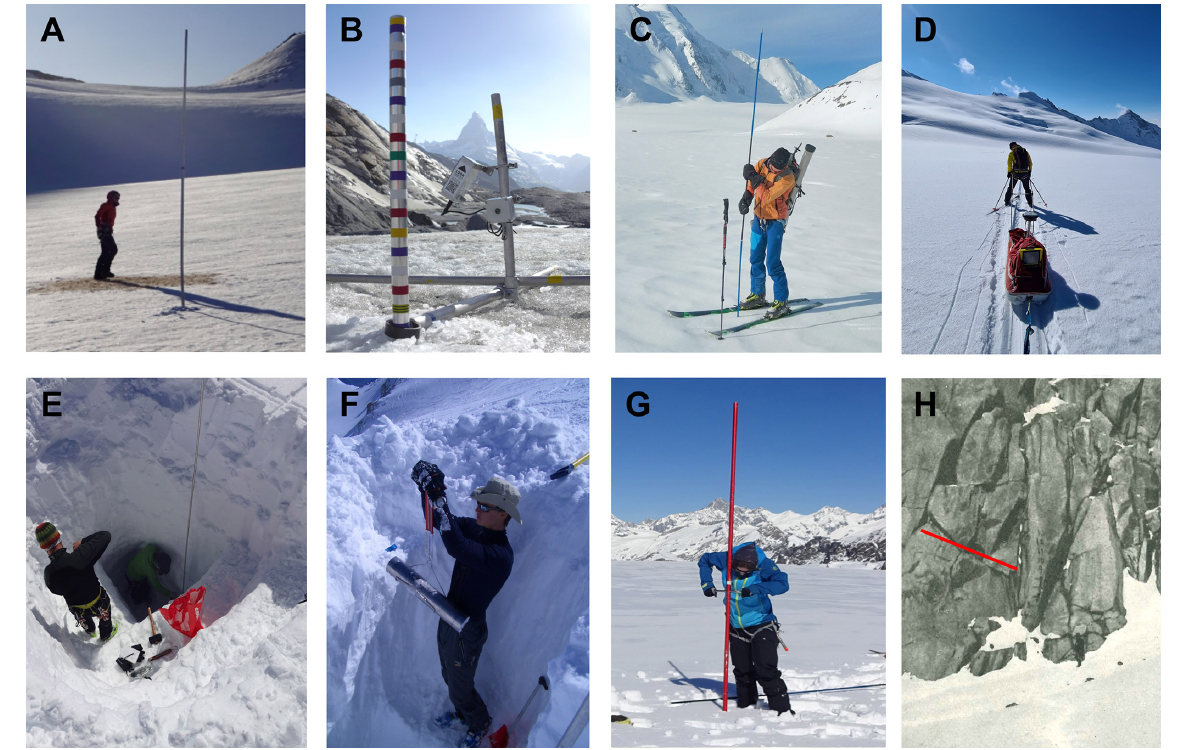
Figure 3. Illustration of different methods of point mass balance data acquisition: (a) mass balance stake and marked horizon (accumulation area), (b) ablation stake with markers and automated camera-based readings, (c) snow probing, (d) ground-penetrating radar for measuring snow layer thickness, (e) snow pit excavation, (f) snow density measurement in a snow pit, (g) coring for snow density measurement, and (h) historic method of nivometers (markers painted on vertical, ice-marginal rocks). Photos: Matthias Huss (a, e–g) , Christophe Ogier (b–d) , Paul-Louis Mercanton (h)